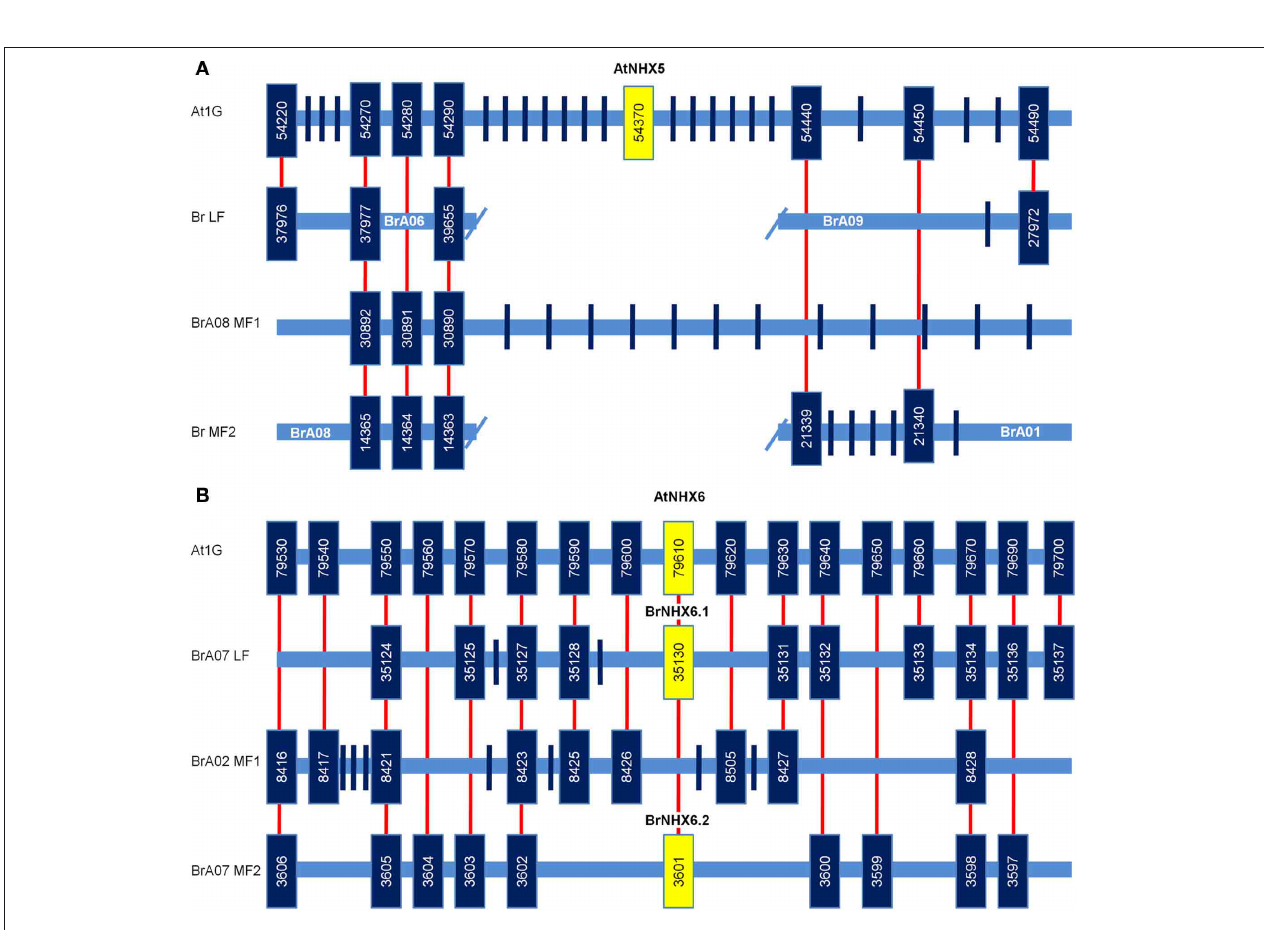
sub-genomes in B. rapa . The boxes and bars denote annotated genes (boxes contain gene accession number) and the red lines connect syntenic homologous genes (Note corresponding genomic regions are not drawn to